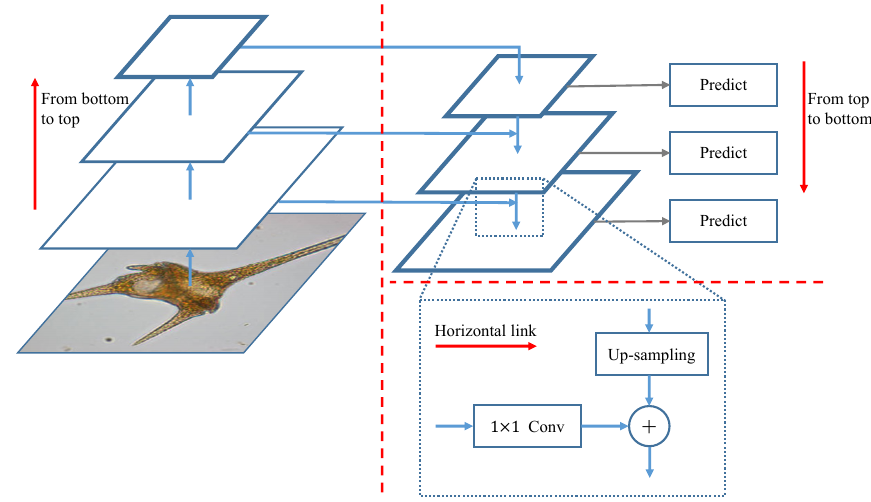
Figure 5. The structure of